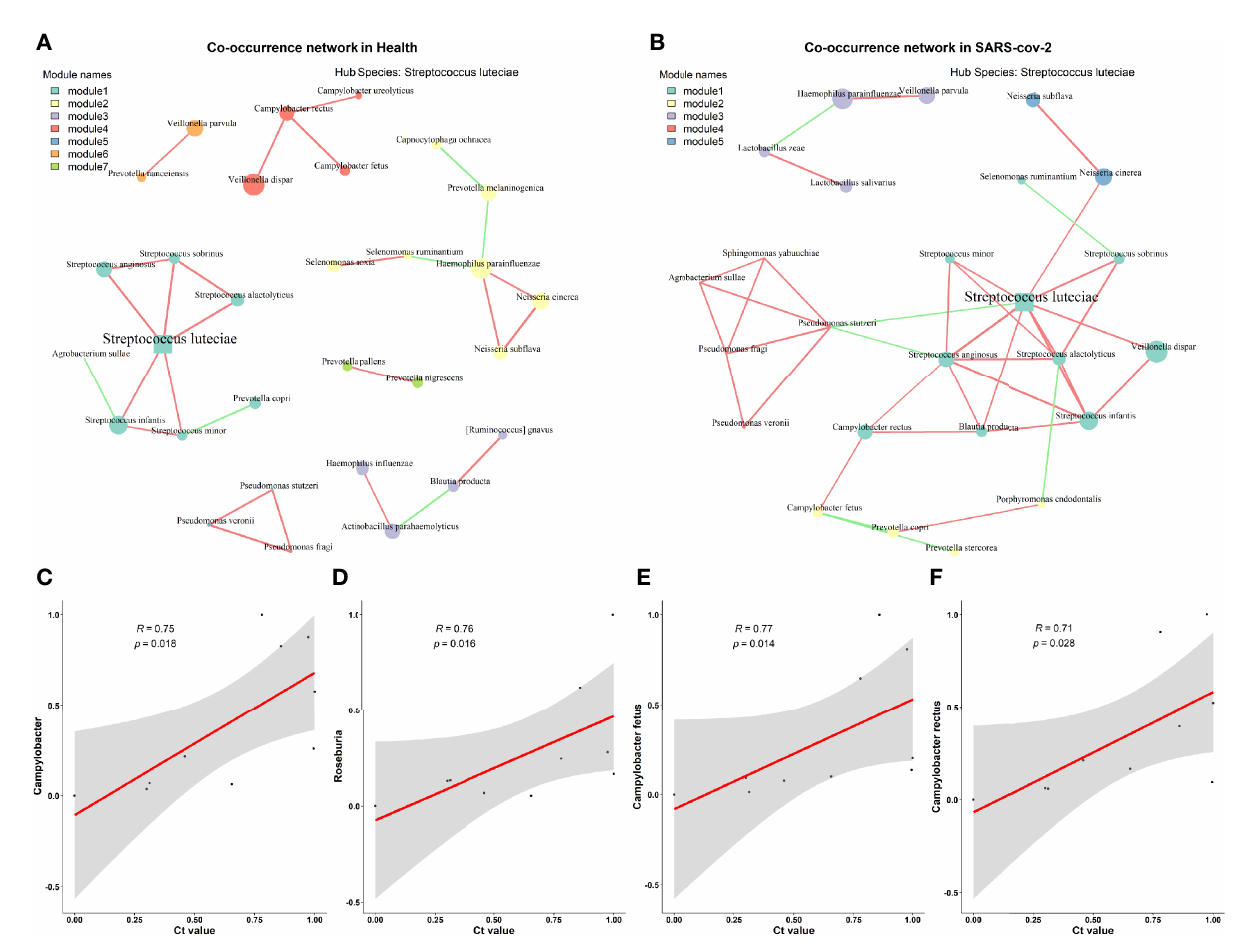
FIGURE 3 | Microbial correlation network between healthy and mild SARS-CoV-2 patients. (A) Healthy controls. (B) SARS-CoV-2 patient. (C – F) Relationships between Ct. values and the differential taxa identi fi ed between higher and lower SARS-CoV-2 viral titer groups at the genus level (C, D) and species level (E, F)